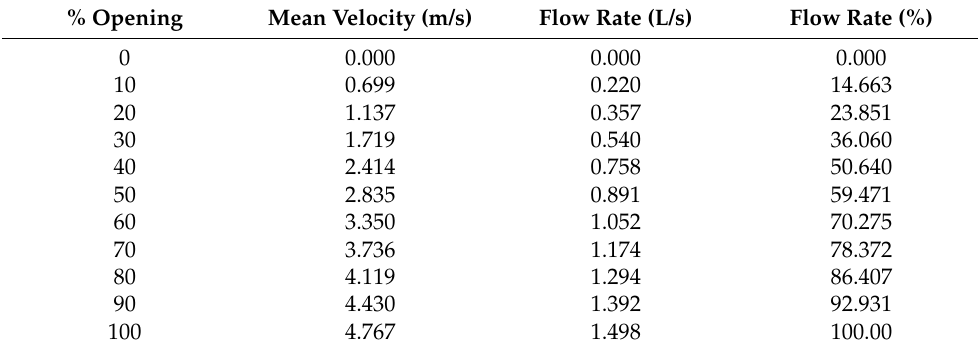
Table 2. Second valve geometry: opening percentage x flow rate.